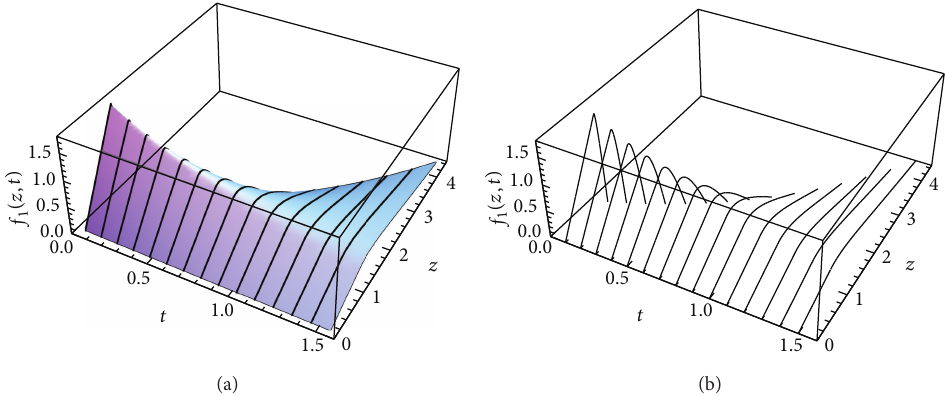
Figure 3: Plots of 𝑓 1 (𝑧,𝑡) given by (54) in Example 12 at different values of 𝑡 = {0.1, 0.2, 0.3, .. ., 1.5} (corresponding to the solid lines in both plots) in the case that (𝑍 0 , 𝐴) is a two-dimensional RV whose PDF is given by (52) and 𝑡 0 = 0 .